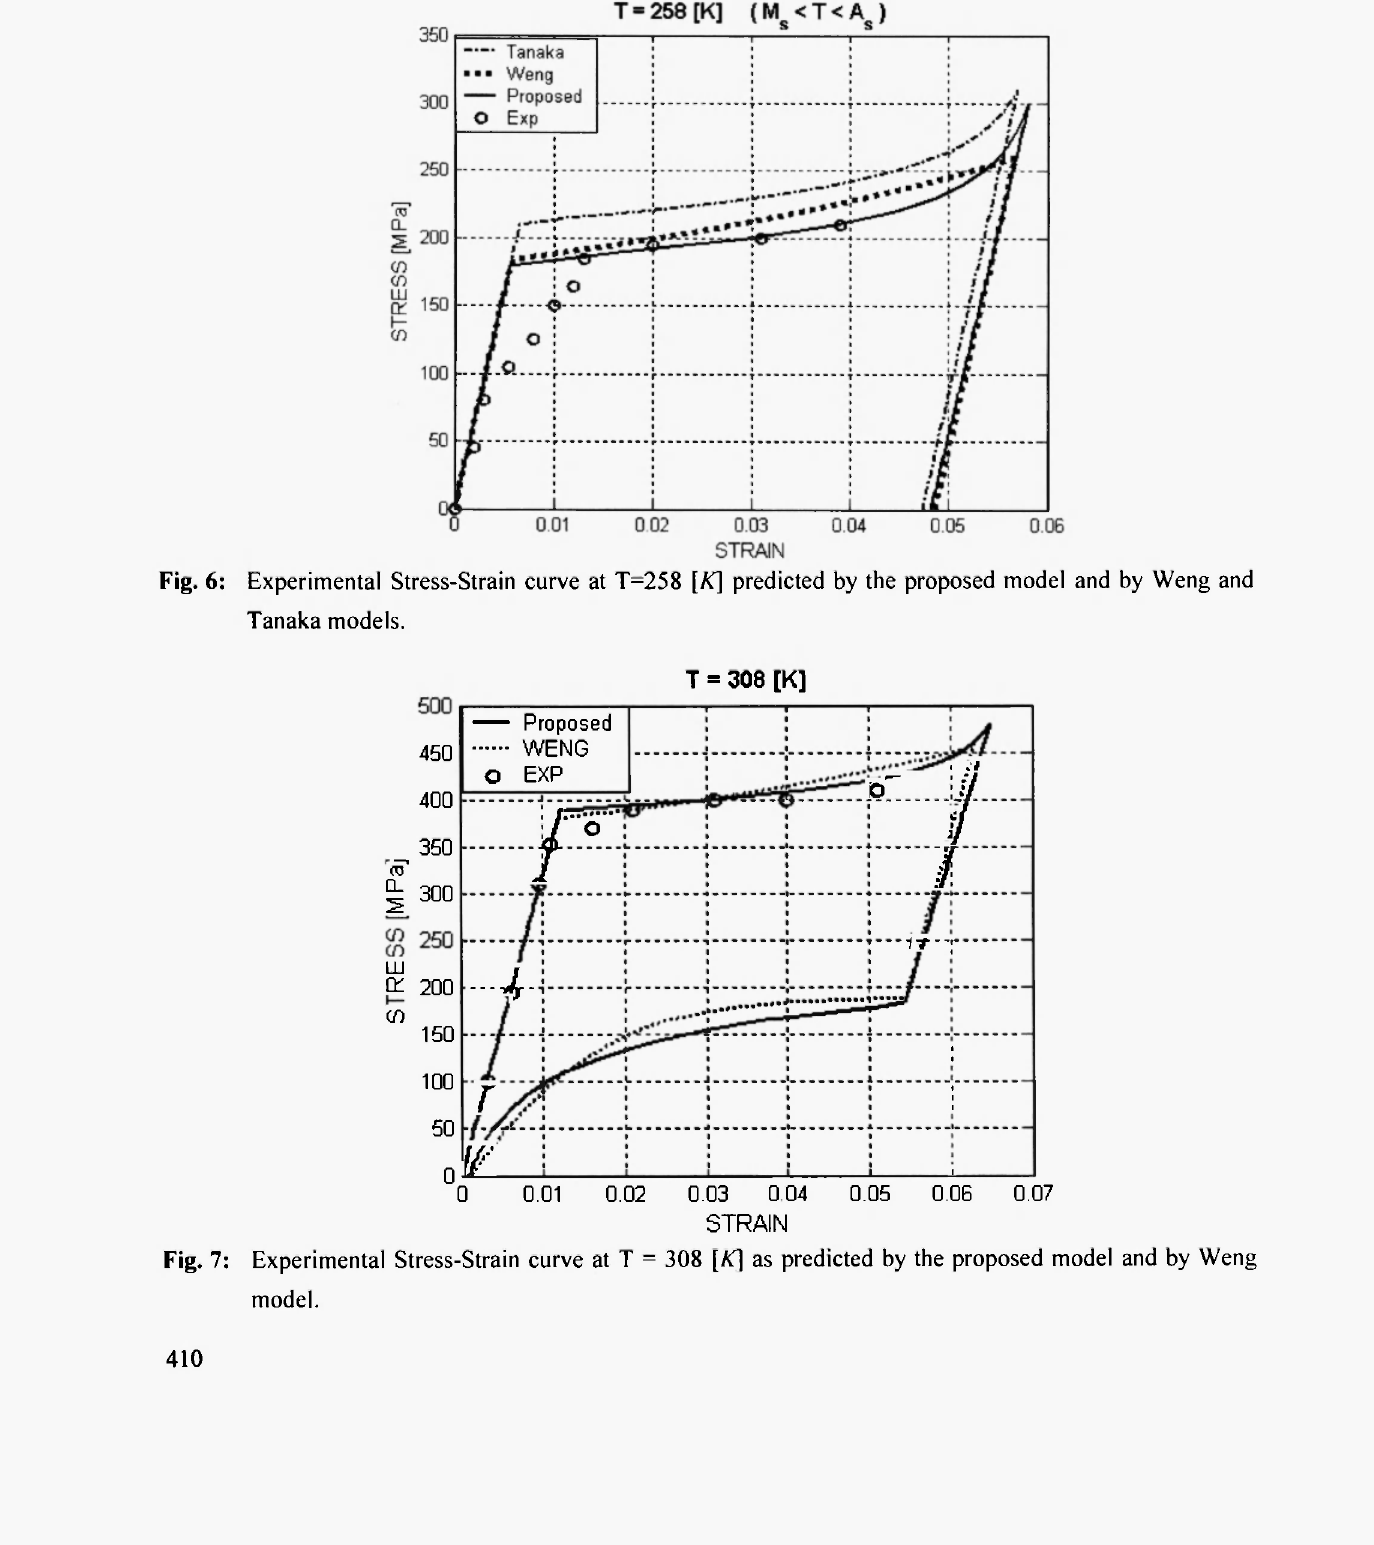
Experimental Stress-Strain curve at Τ = 308 [XT) as predicted by the proposed model and by Weng